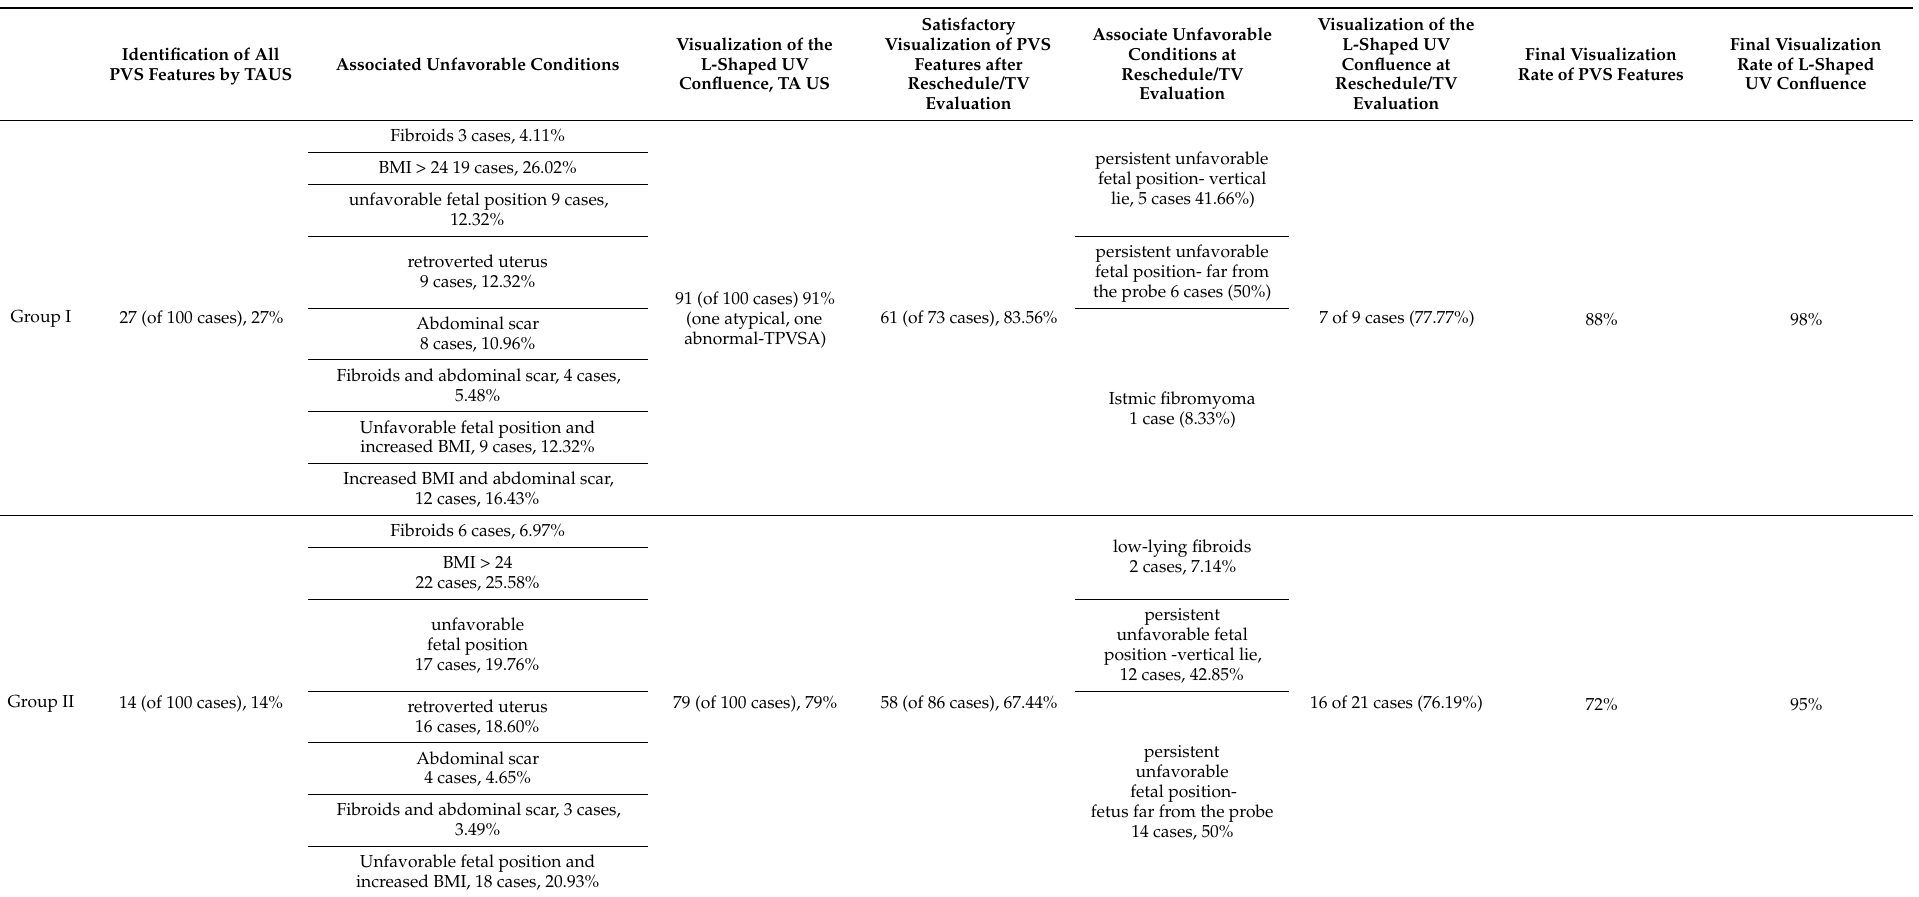
Table 2. The comparative satisfactory evaluation rate of the PVS items in the two groups, reasons for not-satisfactory visualization and the results of alternative